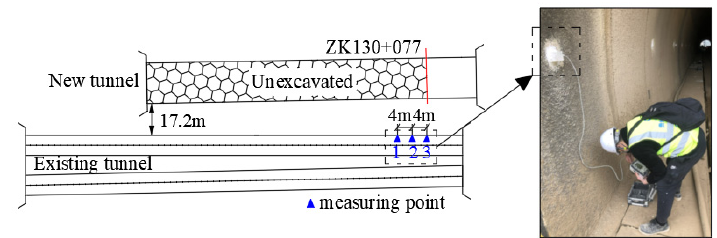
Figure 9. Schematic diagram of measuring point layout.